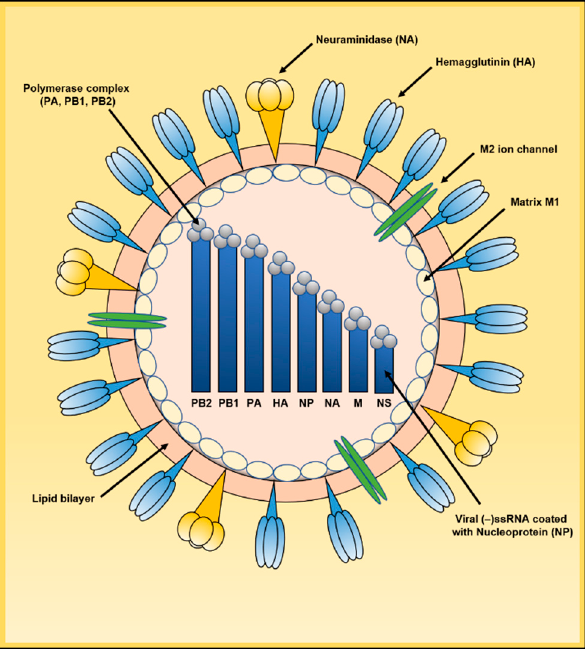
Figure 1. Annotated schematic representation of an IAV virion.